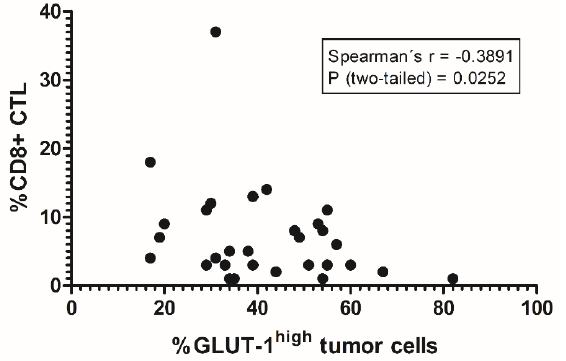
Figure 2. Inverse correlation between the extent of GLUT-1 high expression on tumor cells and cytotoxic T-lymphocytes (CTL) infiltration. On the level of the entire whole-slide images, the amount of GLUT-1 high tumor cells and the strength of the tumor infiltration by CD8 + CTL show a significant negative correlation (Spearman’s r: − 0,39, p = 0.0252). This highlights the observation of systematic avoidance of presumably hypoxic, GLUT-1 high tumor cell areas by CTL. The tumor samples included in this analysis were derived from the following tissues: Brain (2), Skin of the Ear (1), Gastrointestinal tract (1), Lymph node (13), Lung (2), Myocardium (1), Mucosa of the palate (1), Rectum (1), and Skin (11). Statistical analysis was performed using a two-sided Spearman’s correlation